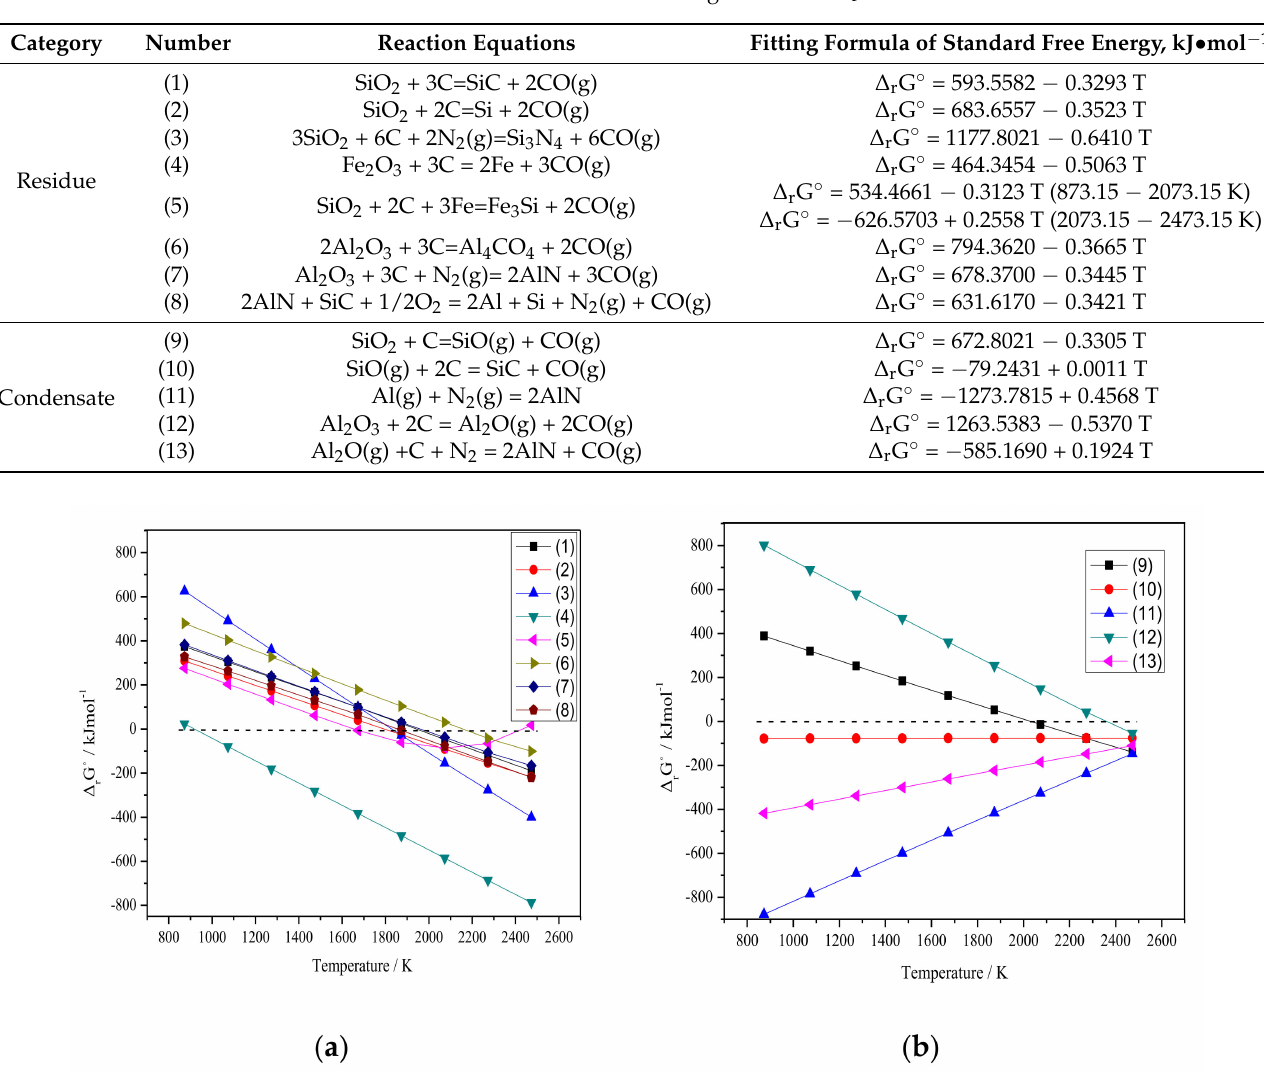
Figure 4. Diagrams of standard free energy versus temperature for reactions (1–13): ( a ) reactions of (1–8), ( b ) reactions of